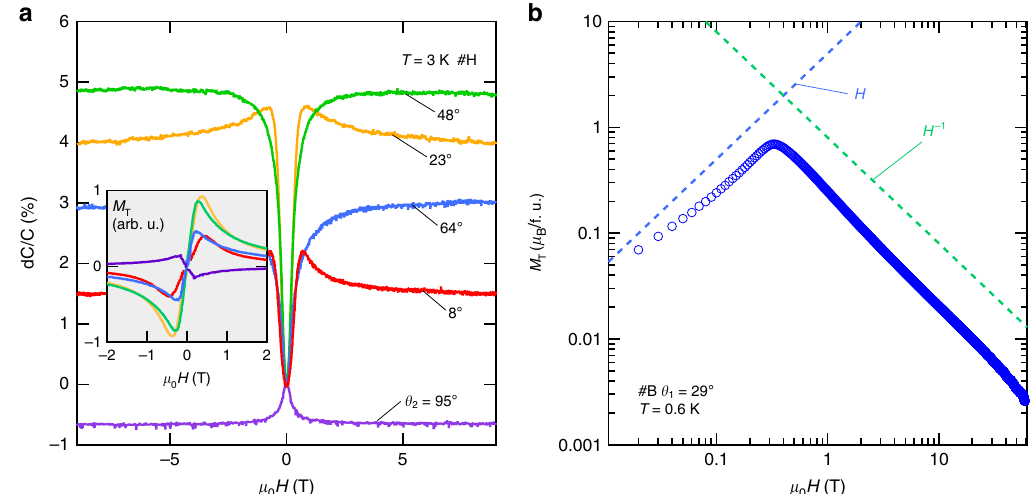
Fig. 4 Torque response from the soft ferromagnetism in Fe 3 Sn 2 . a Low- fi eld magnetic torque at selected angles at T = 3 K measured with a capacitive cantilever in a superconducting magnet. At low angles, the torque response exhibits an initial increase that gradually transforms to a broad shoulder at high angles, consistent with the observation at high fi elds with piezoresistive cantilevers. The inset shows the transverse magnetization extracted for each torque curve. b Pulsed fi eld transverse magnetization M T up to 60 T at θ 1 = 29° at T = 0.61 K shown in a log – log scale. M T attains a maximum ~0.7 μ B per formula unit below 1 T and at higher fi elds follows an approximately H – 1